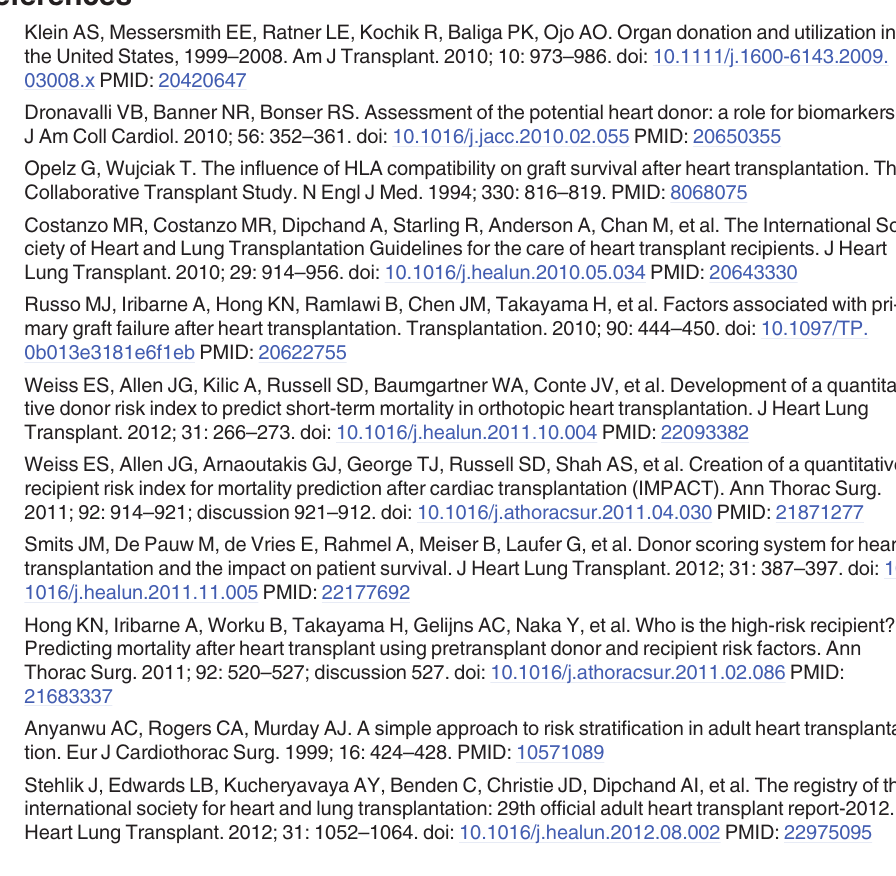
S2 Table. Time-dependent hazard ratios for different subgroups. S3 Table. Organ allocation simulation. Influences of the allocated organs, and the predicted and observed survival time depending on the waiting list size, using the IHTSA model, Clinical model respectively by random. A) Applied on the internal validation cohort. B) Applied on the external validation cohort, Nordic Thoracic Transplantation